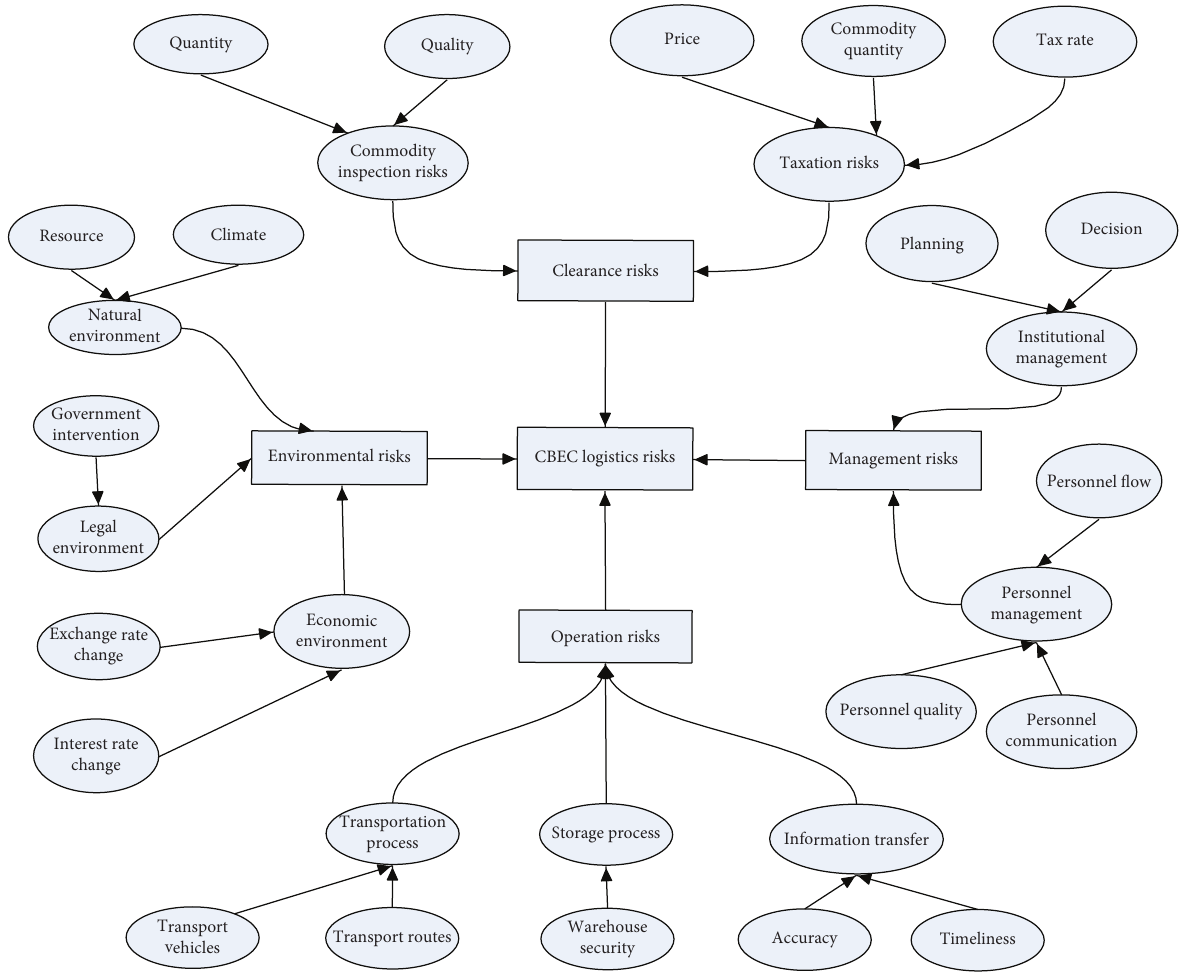
Figure 2: Bayesian model for the warning of CBEC logistics risks. Table 1: Value assignment to origin